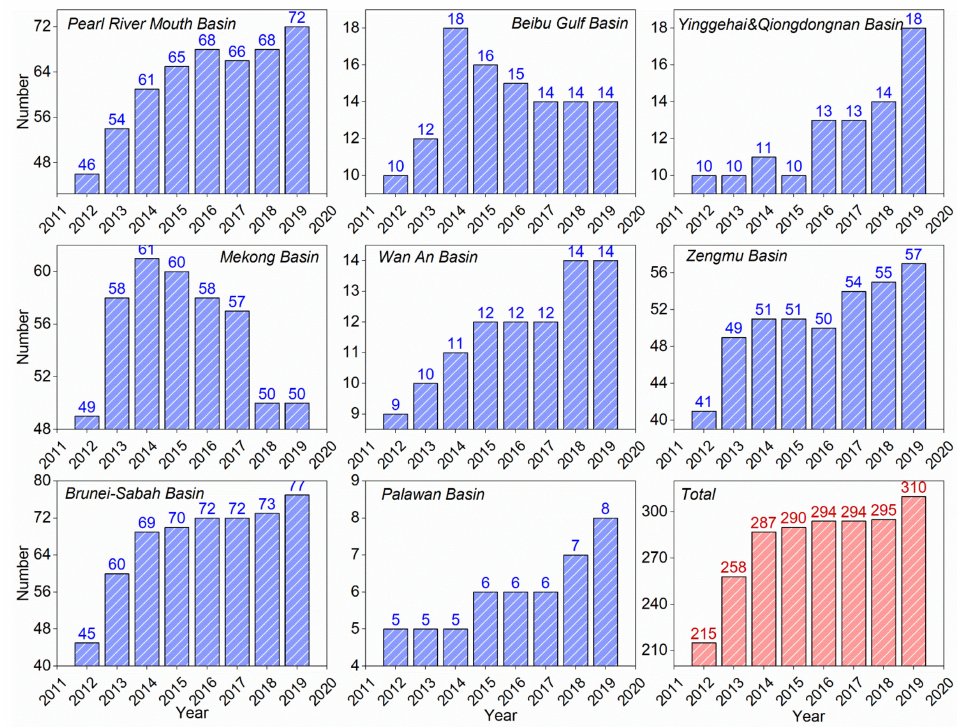
Figure 10. Changes in the quantity of offshore HE targets from 2012 to